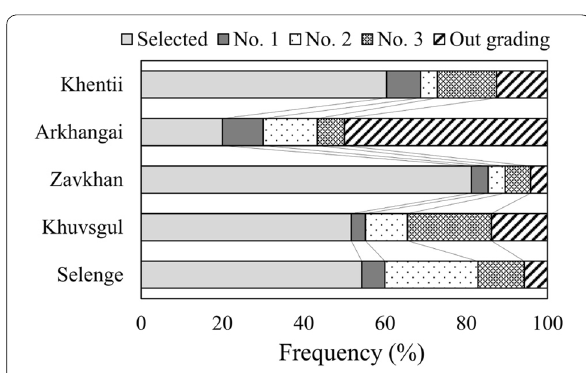
Fig. 4 Percentage of each grading class of lumber in each provenance